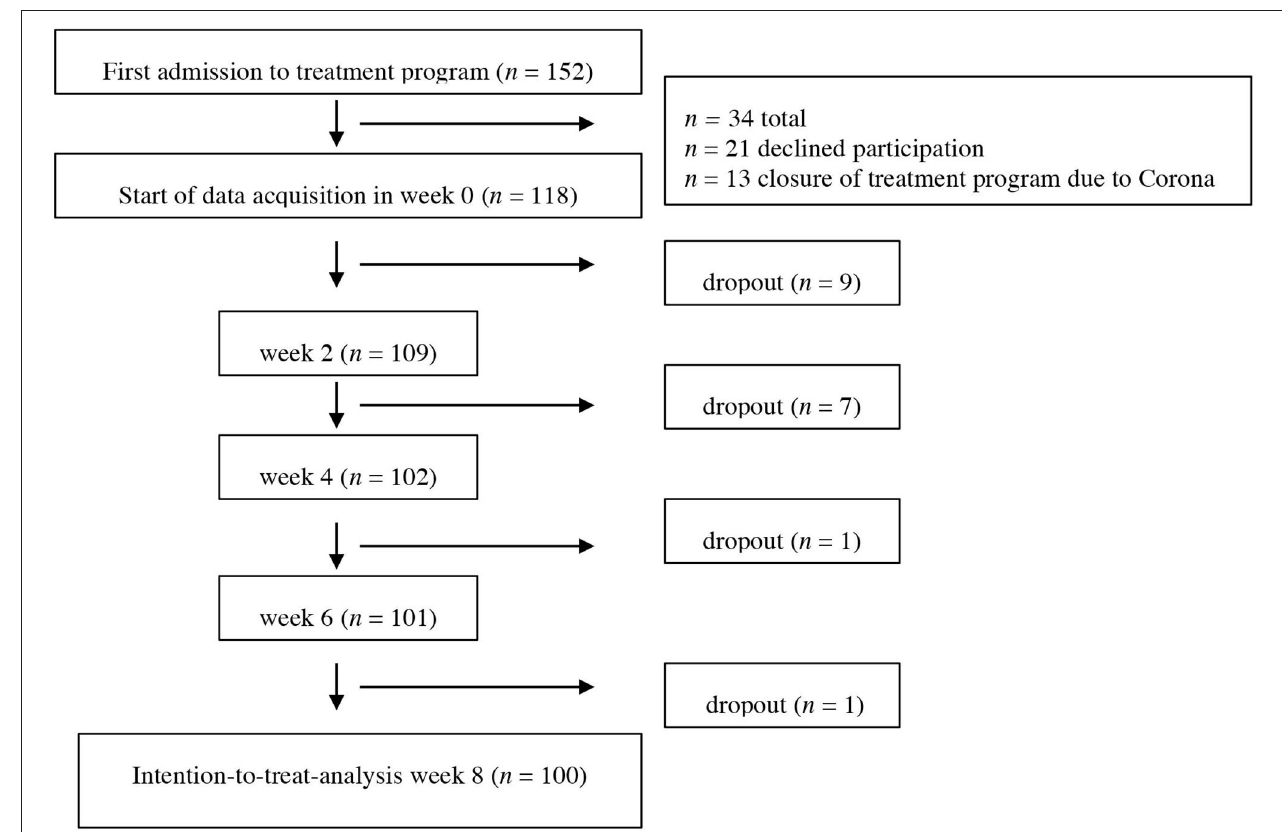
FIGURE 1 | Flowchart of participants. Dropout is referring to cases that were missing data (more than 20% or missing all data points needed for